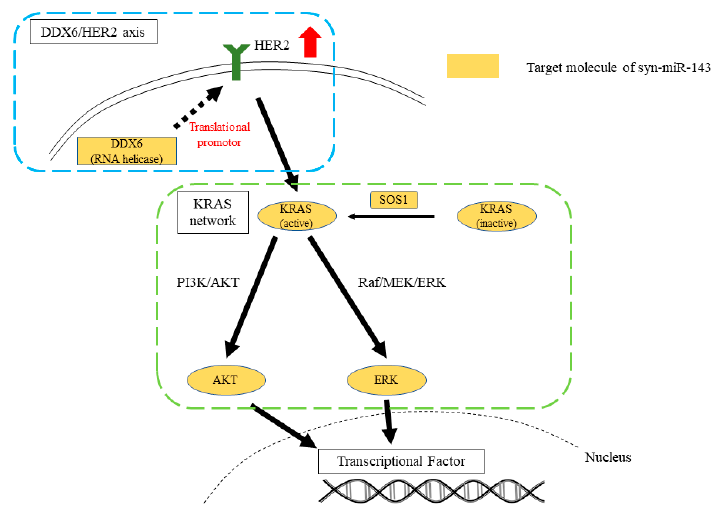
Figure 6. Schematic diagram demonstrating the effect of syn-miR-143 on the signaling pathways of HER2/KRAS network and HER2/DDX6 axis in gastric cancer cells. The genes colored in orange are direct targets of syn-miR-143. The dotted line and red arrow demonstrates that DDX6 enhances the HER2 protein expression.